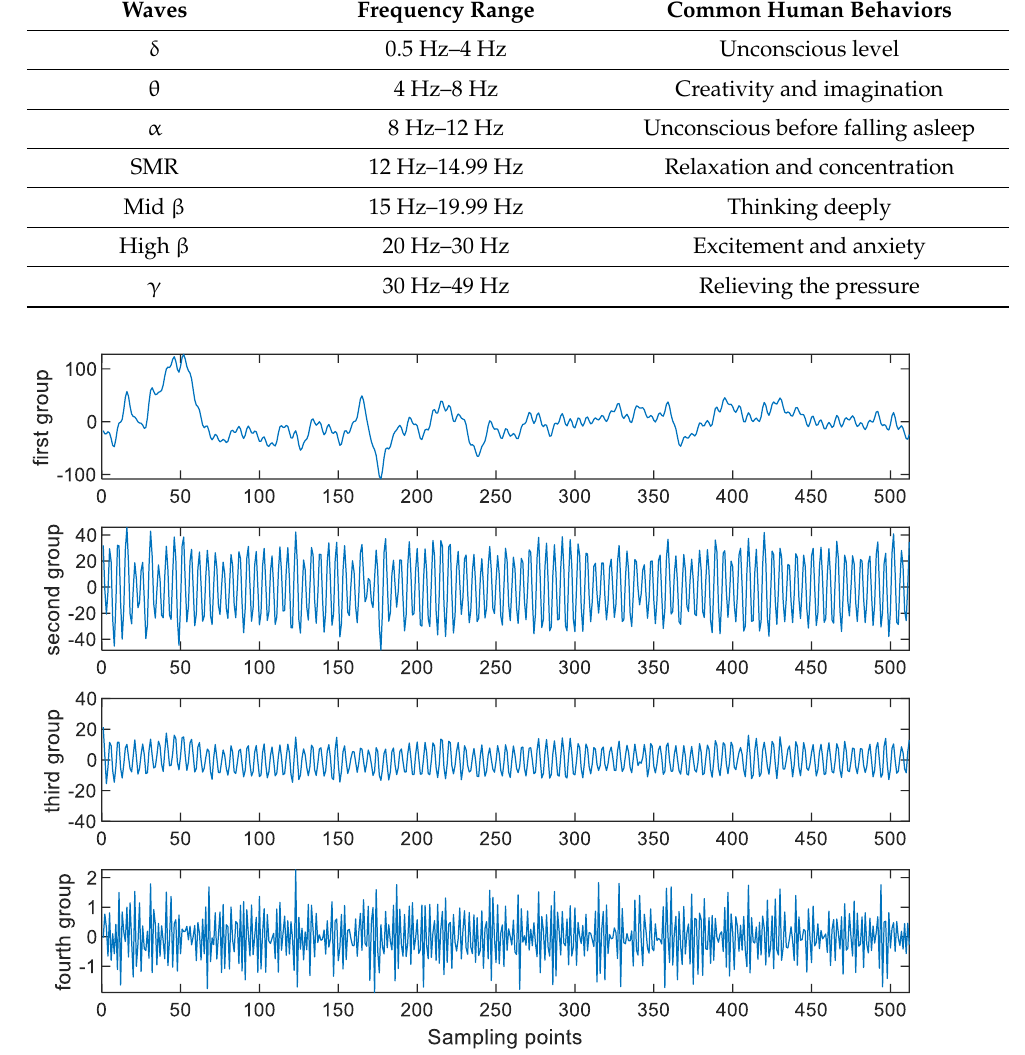
Table 3. The common human behaviors and the brain waves responsible for these human behaviors.